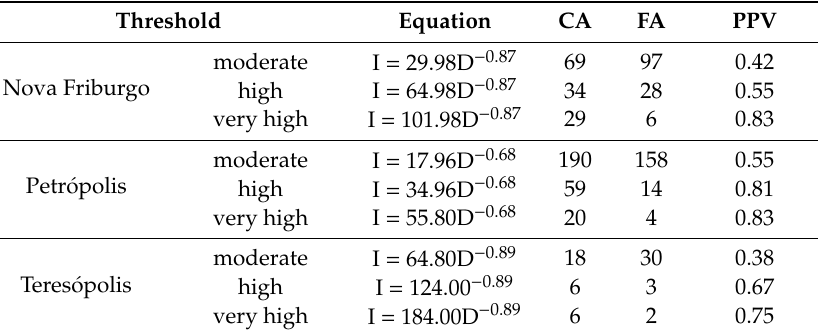
Table 3. Thresholds equations and parameters.